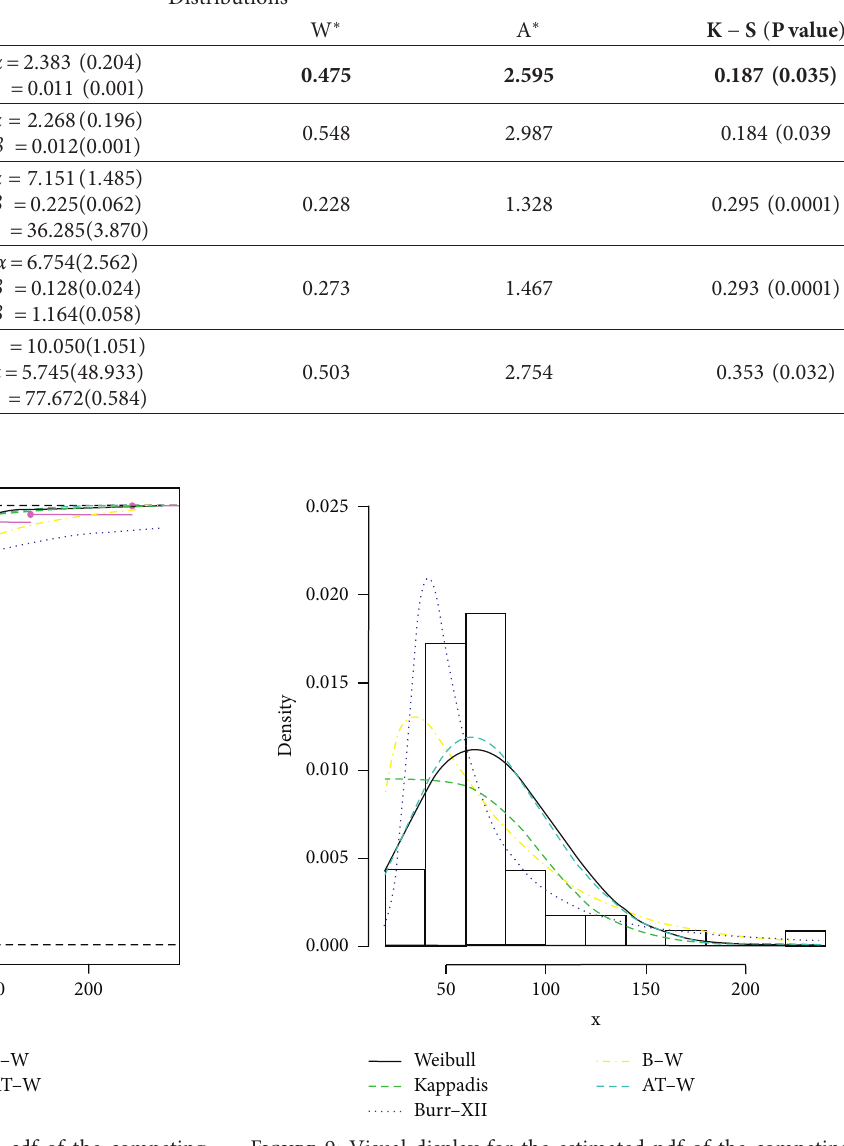
Figure 8: Visual display for the estimated cdf of the competing models.